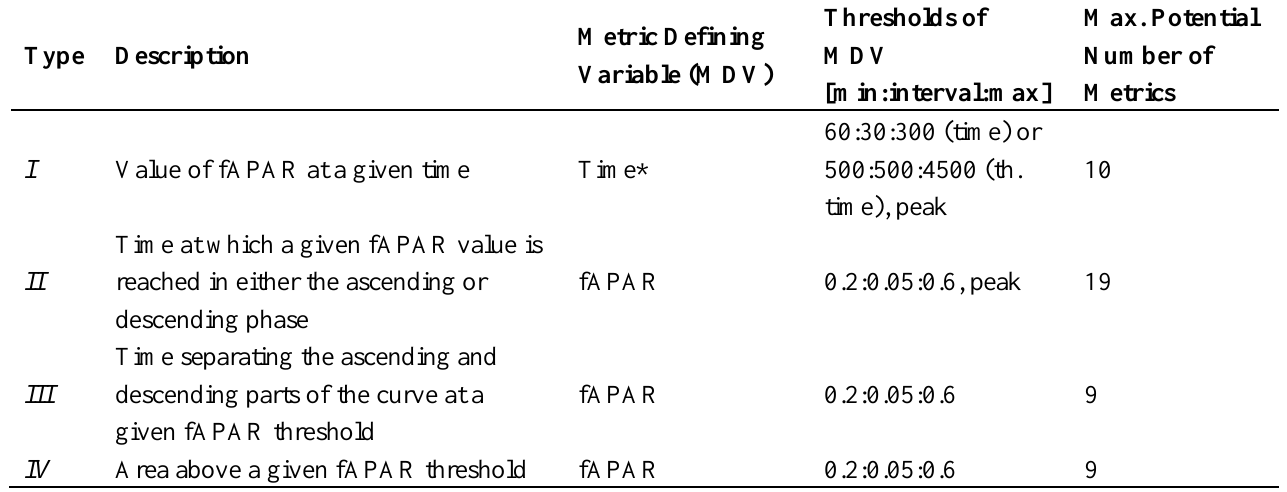
Table 1. Synthesis of the fAPAR metric